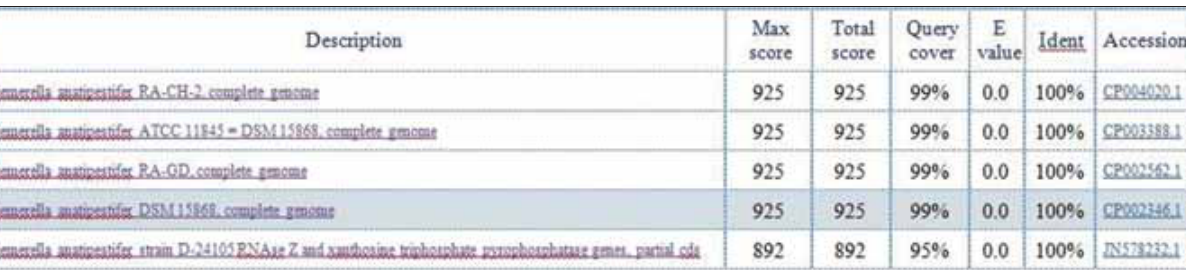
Figure-4: The NCBI blast search analysis of the sequenced DNA of field isolate of Riemerella anatipestifer with the published